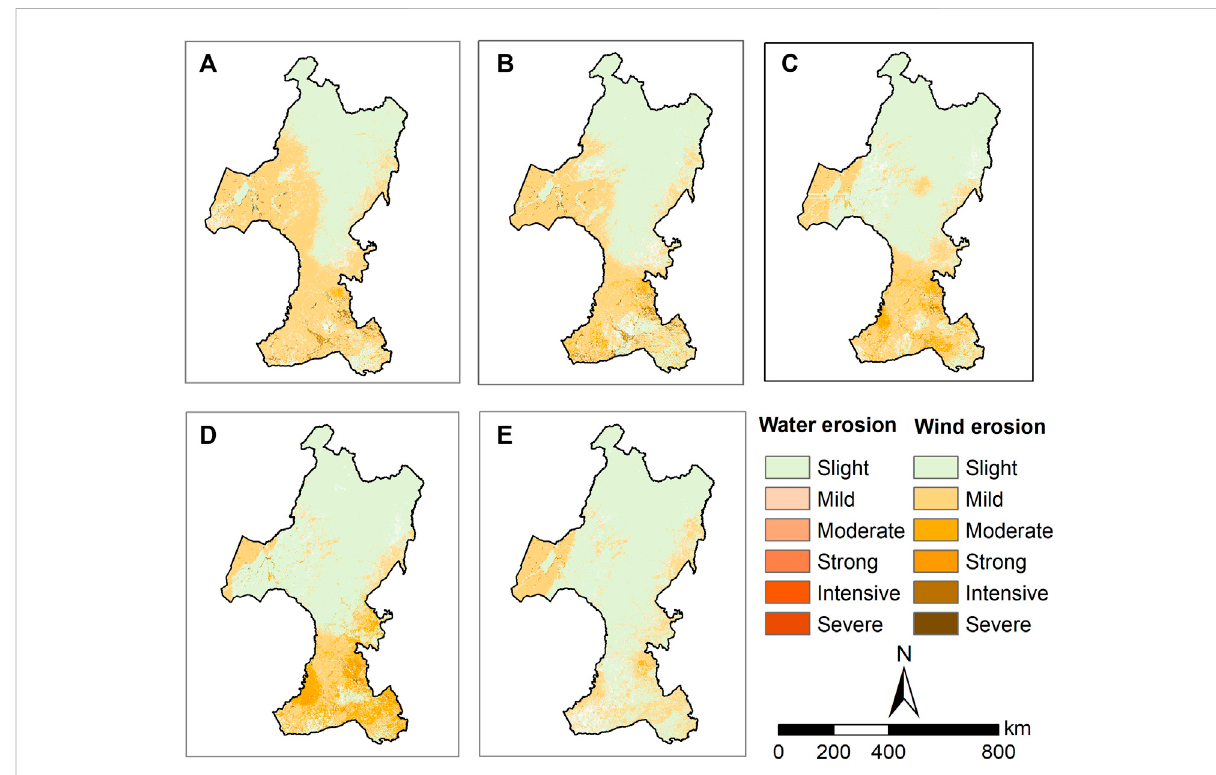
FIGURE 2 Soil erosion spatial pattern dynamic change in Northeast Inner Mongolia. (A) 1978, (B) 1985, (C) 1995, (D) 2005, (E)